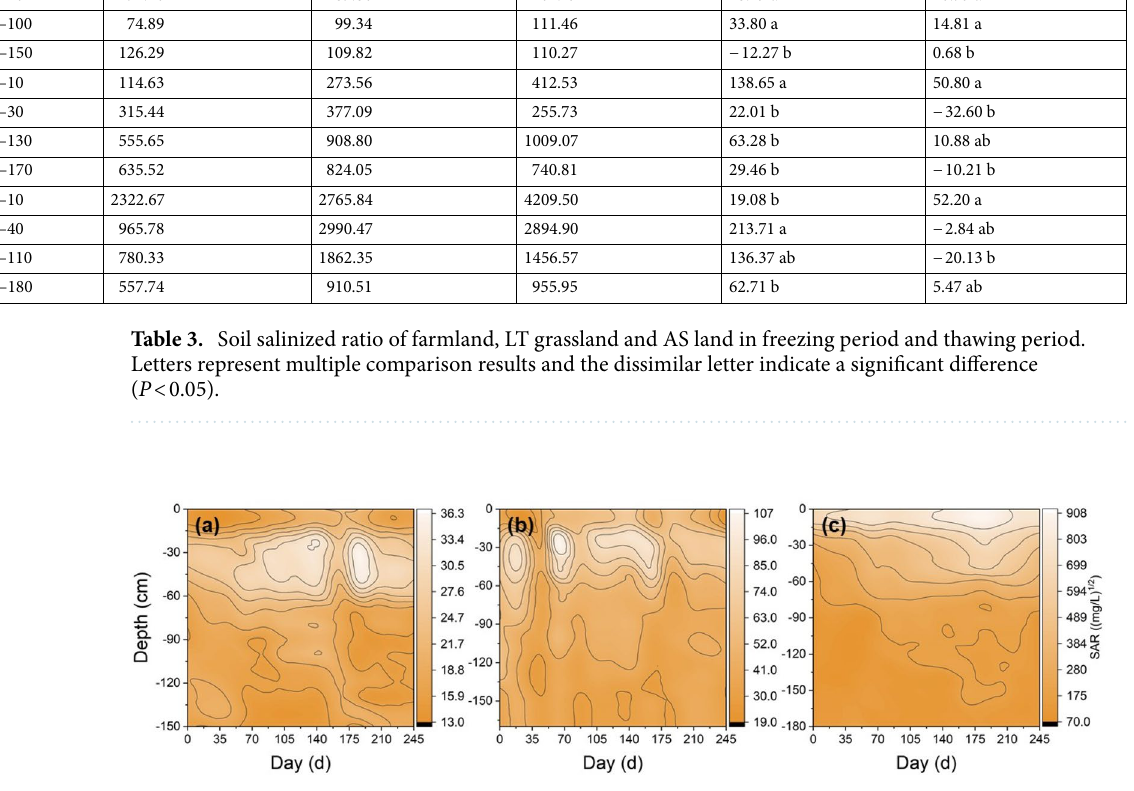
Figure 8. Contour map of soil SAR in farmland ( a ), LT grassland ( b ) and AS land ( c ) from 24 October, 2015 to 25 June,